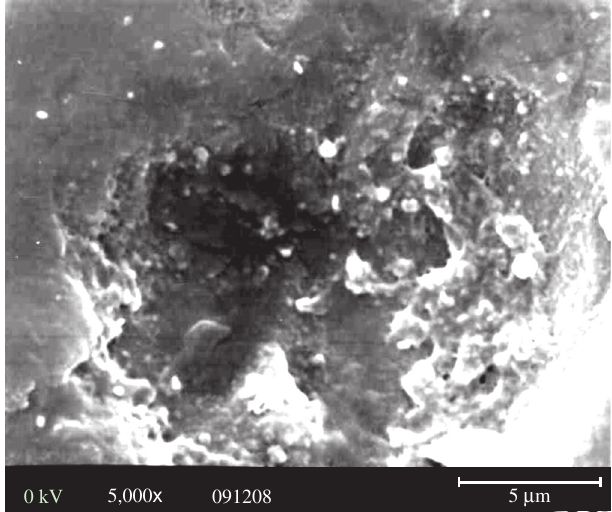
Figure 3. SEM of corrosion area of CP Ti polished surface observed after S. mutans biofilm